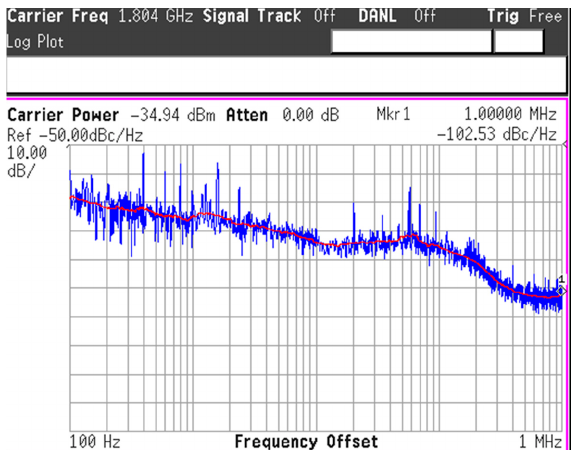
Figure 20. Measured phase noise of the fractional- N PLL.